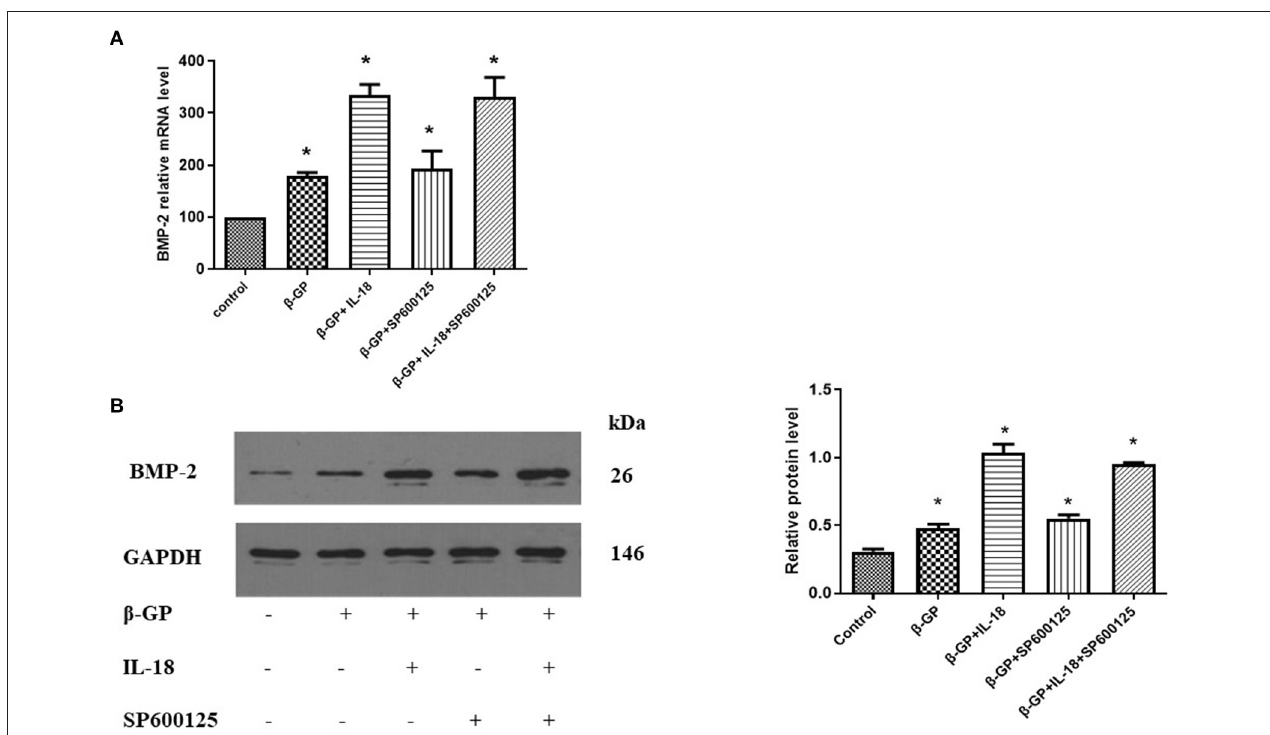
FIGURE 13 | Effect of JNK pathway on IL-18-induced osteogenic phenotypic transformation of rat VSMCs. (A) Effect of JNK pathway on the expression of BMP-2 mRNA of rat VSMCs after IL-18 intervention. (B) Effect of JNK pathway on the expression of BMP-2 protein of rat VSMCs after IL-18 intervention. Rat VSMCs were